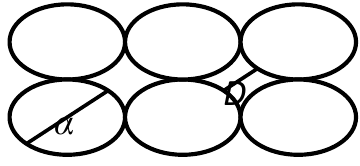
Figure 8. A simple 2D model of the spherical oxide granules of size α and pore sizes, D